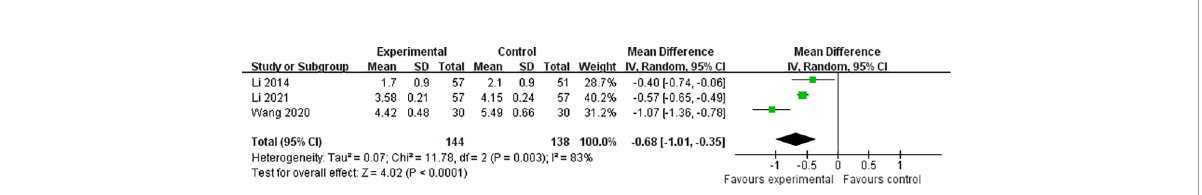
FIGURE 7 Forest plot of effects of acupuncture combined with metformin versus metformin alone on